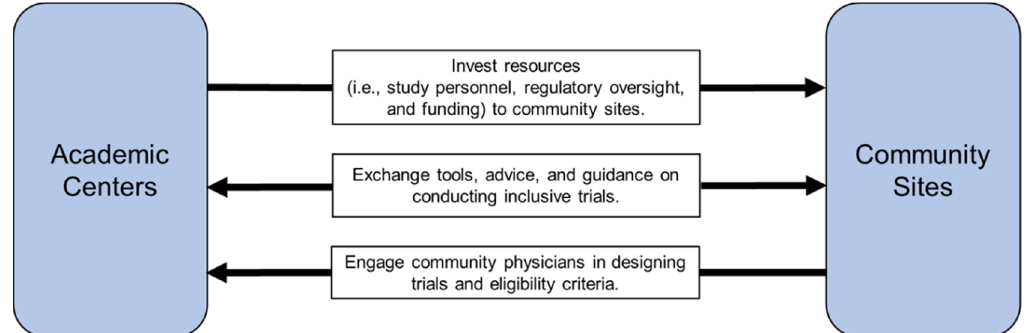
Figure 2. Strategies to connect academic centers and community-based practices. Ensuring collaboration between academic centers and community sites is essential in improving the participation of older adults in cancer research. First, academic centers should invest resources such as study personnel, regulatory oversight, and funding to community sites in order to help create trials and participation where most patients receive treatment. Second, both community sites and academic centers need to exchange tools, advice, and guidance to help increase the quality of trials being done and make sure that the needs of older adults are met. Lastly, community sites must have their clinicians participate in the designing of trials and eligibility criteria so that trials better fit the present patient